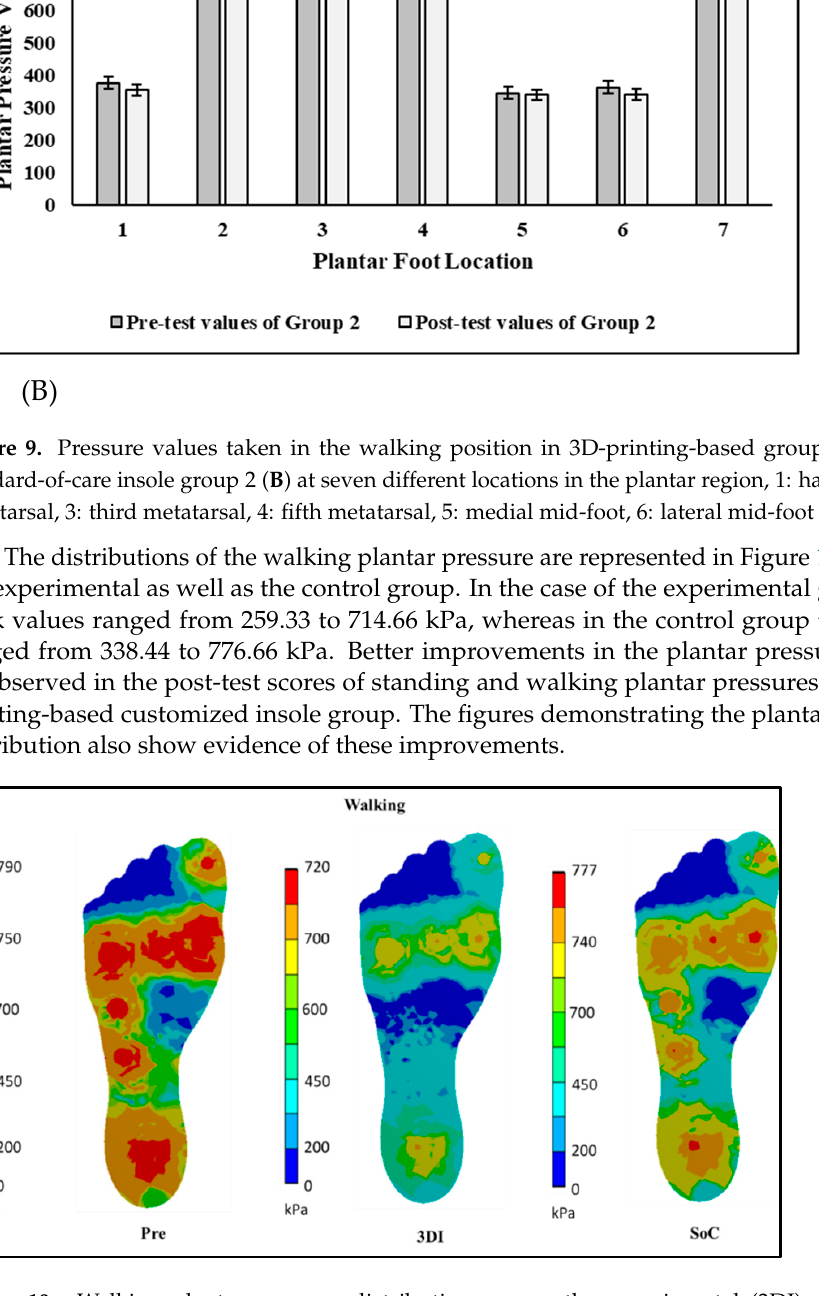
Figure 10. Walking plantar pressure distributions across the experimental (3DI) and control (SoC) groups .